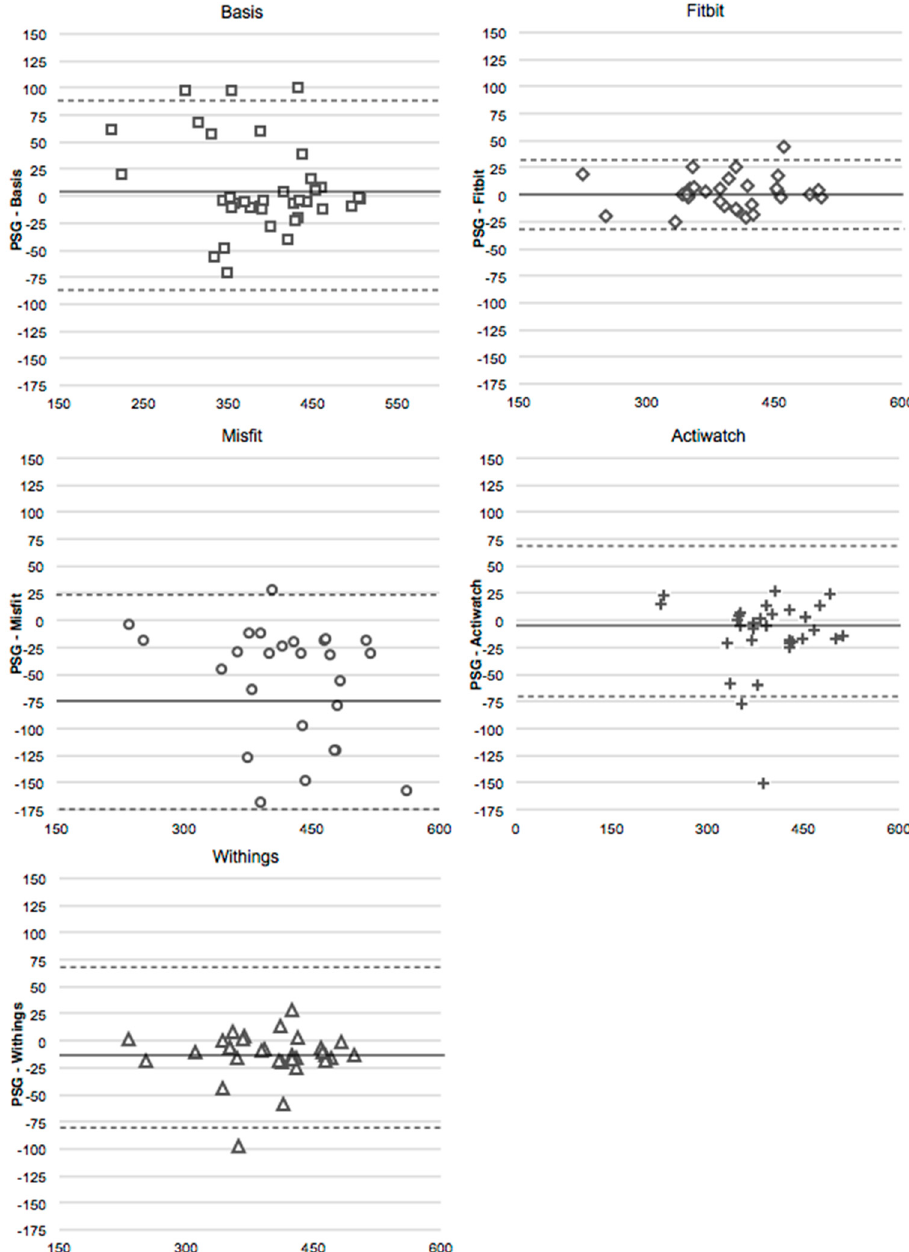
Figure 1. Bland-Altmann plots for total sleep time (minutes) for the Basis, the Fitbit, the Misfit, the Spectrum, and the Withings compared to PSG (adjusted values). The x-axis is the mean of the two devices, and the y-axis represents PSG minus the device. Dotted line represents two standard deviations from the mean.